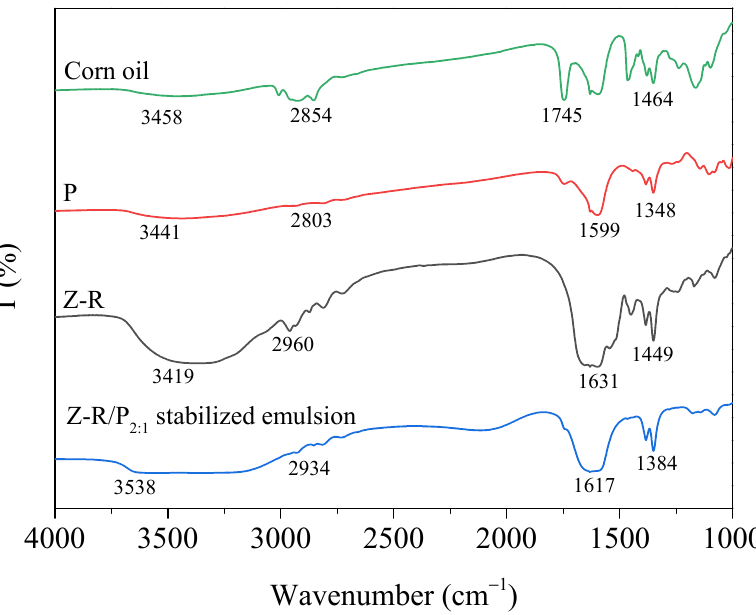
Figure 7. FTIR spectra of corn oil, zein–resveratrol Z-R conjugate, pectin (P) and Z-R/P 2:1 -stabilized emulsion.